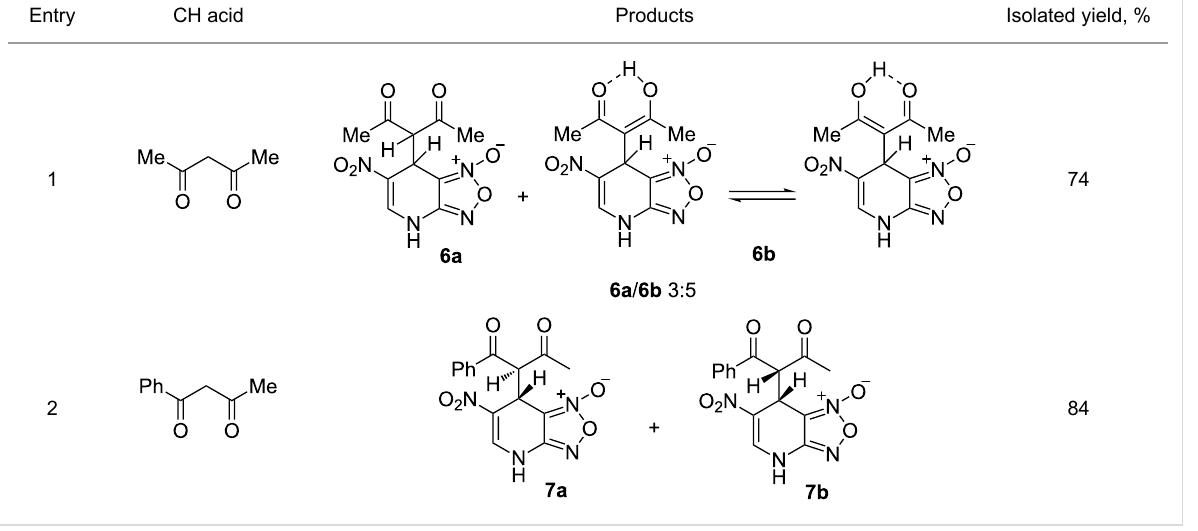
Table 1: Reactions of ANBF with β -dicarbonyl